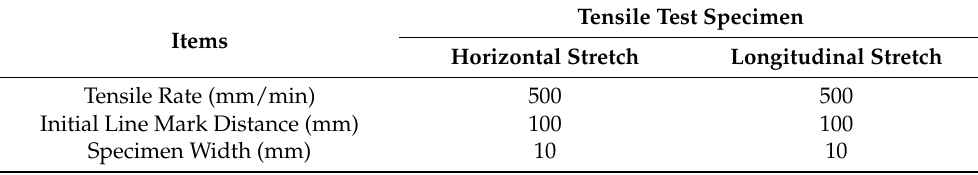
Table 1. Tensile Test Condition